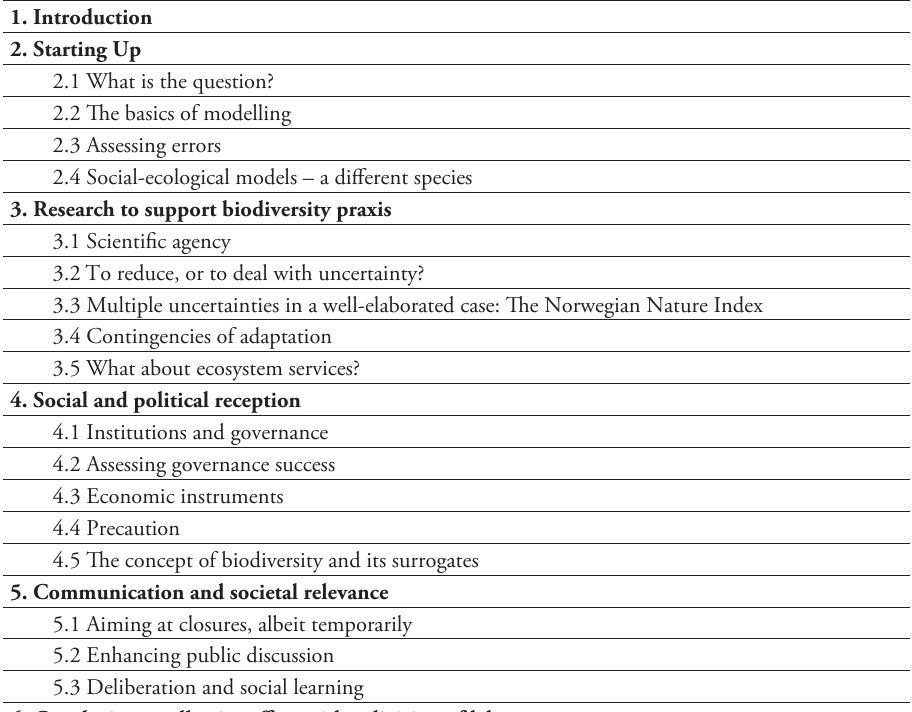
Table 1. The structure of the